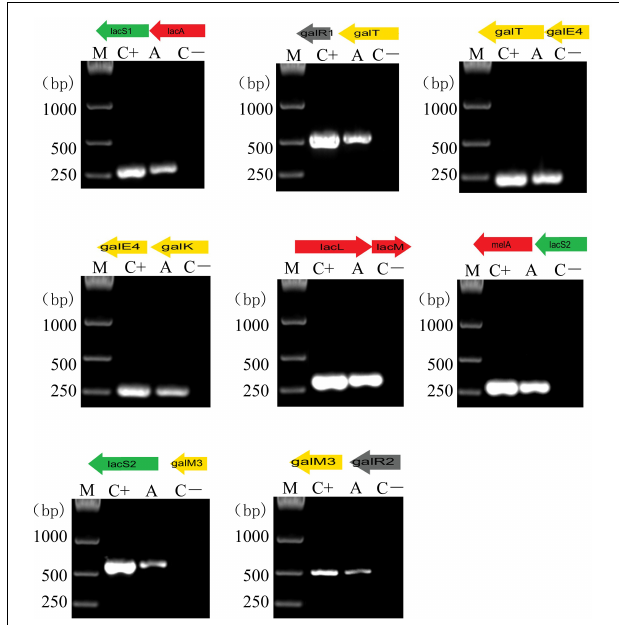
FIGURE 6 | RT-PCR analysis of the transcriptional organization of lac and gal clusters in L. plantarum ST-III. M, DNA size marker; C+, positive control using chromosomal DNA of the strain as the template; A, fragment amplified with a specific primer set using cDNA generated from GOS-induced L. plantarum ST-III as the template; C − , negative control using total RNA without the reverse transcription step. Primers used are listed in